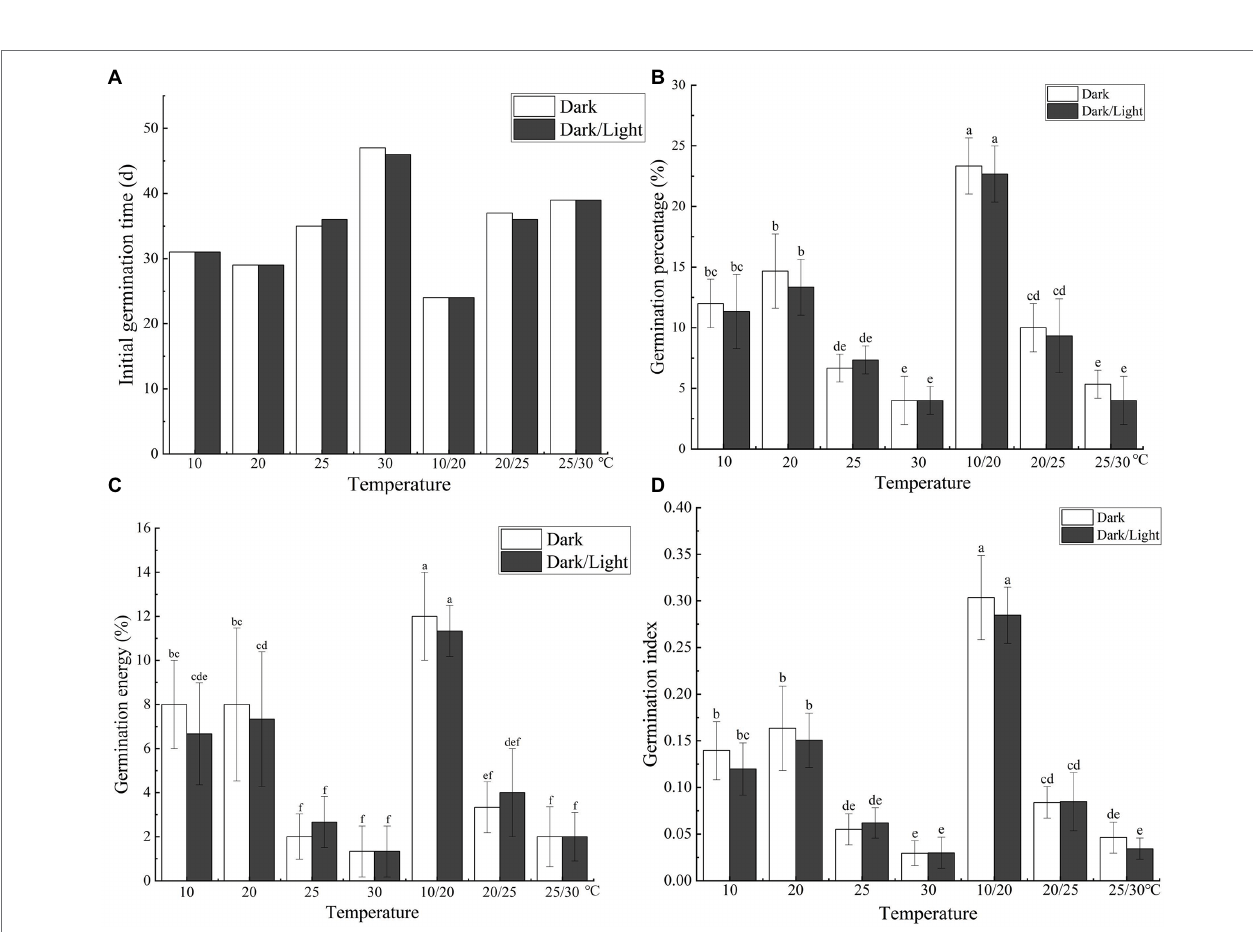
FIGURE 7 | Effects of temperature and light treatments on the germination characteristics of Cinnamomum migao seeds. Data are presented as means ± standard deviations ( n = 3), and the values marked with different letters in different treatments vary significantly ( p < 0.05). Three replicates of 50 seeds were used in the germination test. (A) Initial germination time, (B) germination percentage, (C) germination energy, (D) germination